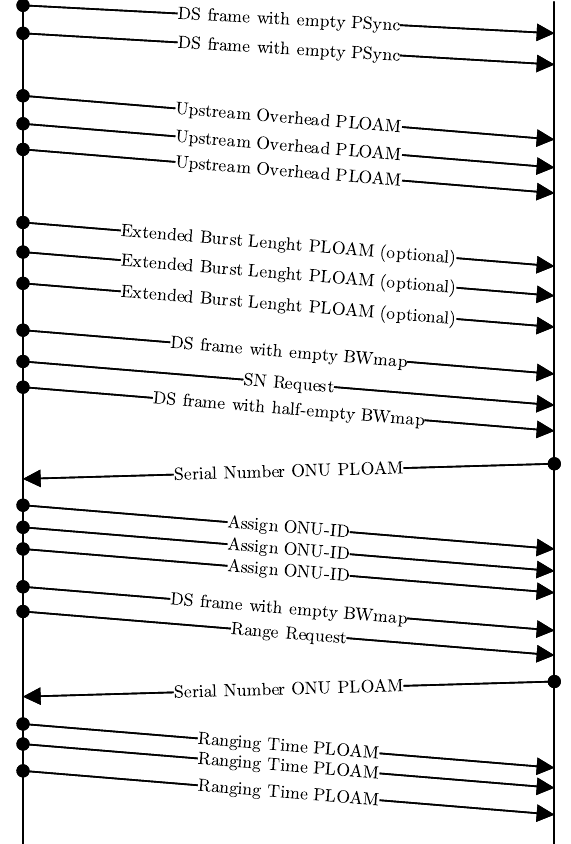
Figure 6. Physical layer operation, admission, and maintenance (PLOAM) messages exchange